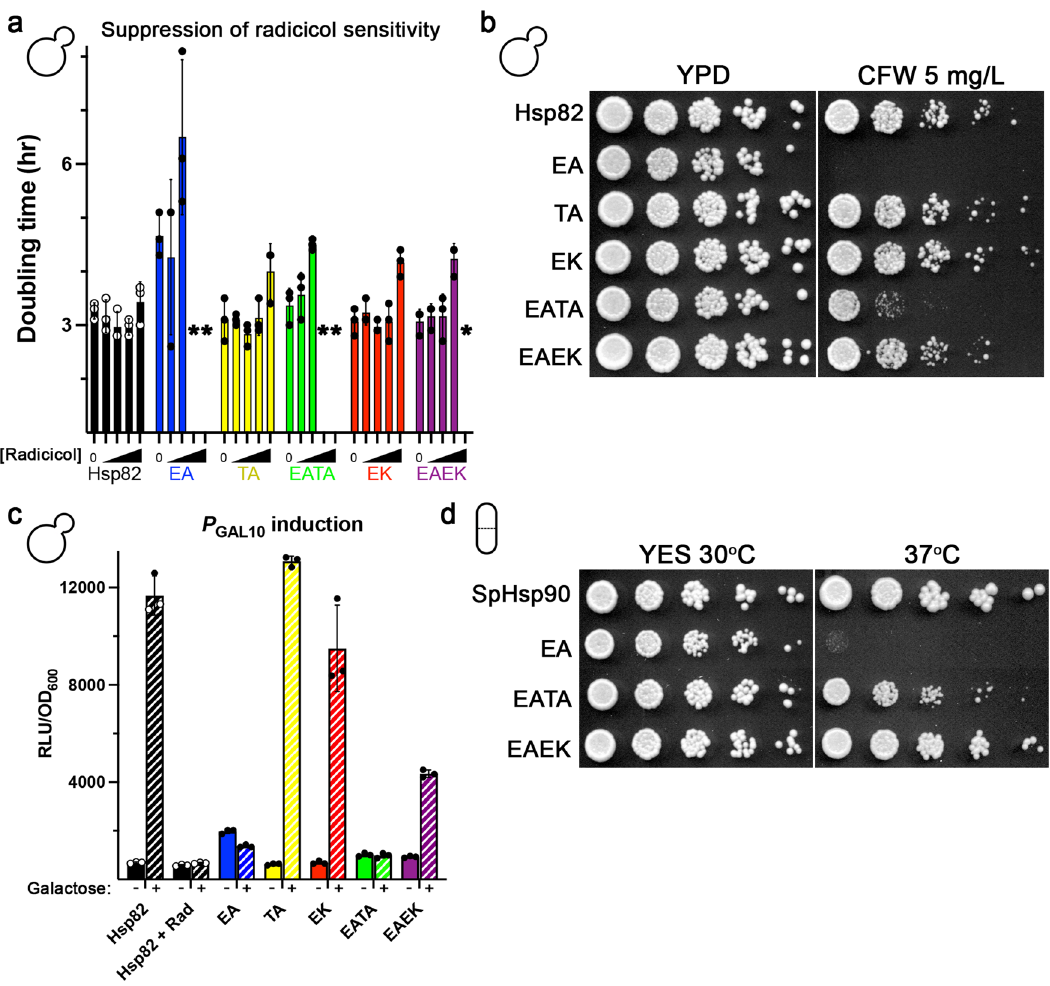
Fig. 5 | The TA and EK mutations rescue EA-mediated defects in conditional phenotypes to varying degrees. a S. cerevisiae cells expressing EATA or EAEK versions of Hsp82 were less sensitive to radicicol (concentrations: 0, 1, 3, 10 and 30 μ M) than cells expressing Hsp82-EA. Asterisks (*) denote conditions under which no growth was observed. b S. cerevisiae cells expressing Hsp82-EATA or -EAEK were less sensitive to CFW than cells expressing Hsp82-EA. c EK partially